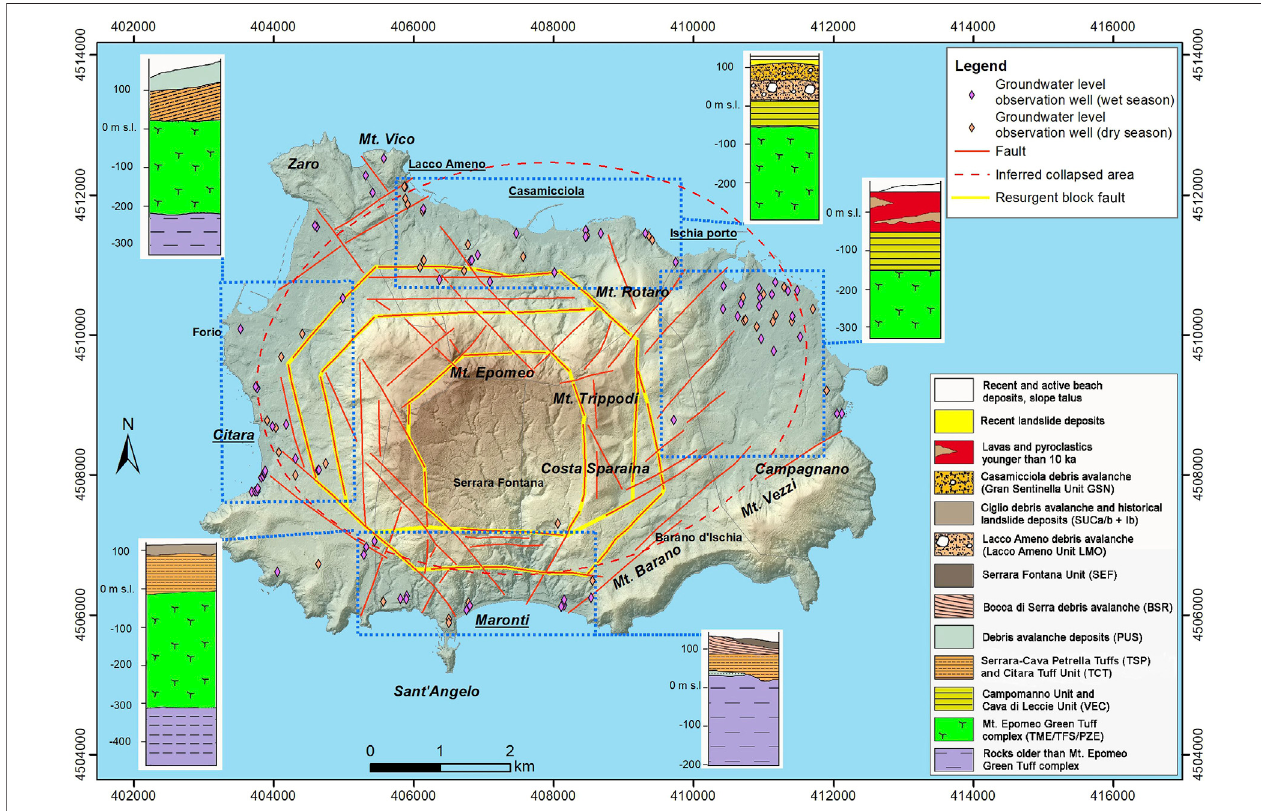
FIGURE 5 | Stratigraphical and structural sketch map of Ischia Island. Available groundwater level datasets are shown; site descriptive information includes well depths and stratigraphic logs. The blue dashed lines highlight the delimitation of four distinct sectors used for the reconstruction of a reliable potentiometric surface. For each sector, the stratigraphic type section is reported based on the drilling information. DEM details are in Figure 2 .